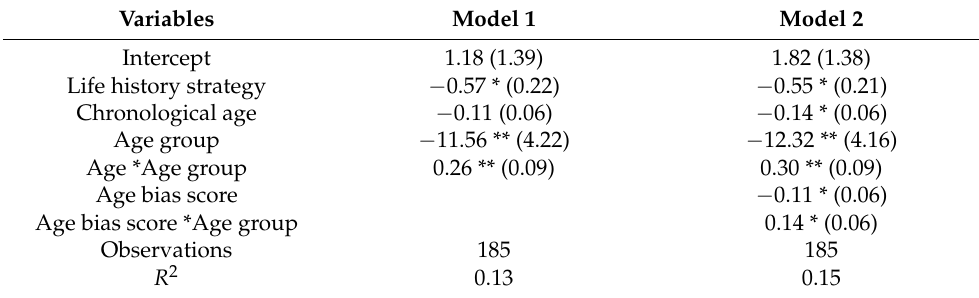
Table 2. Robust Regression Estimates Predicting Delay Discounting.